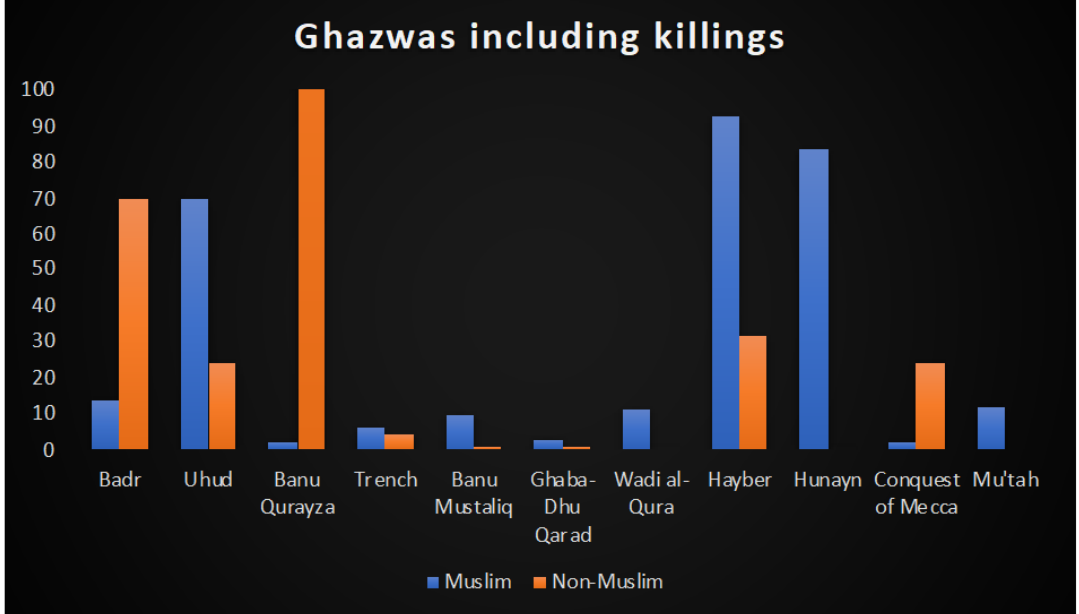
Figure 1. Ghazwas in Islamic history. (Source: Forum for Promoting Peace in Muslim Societies’ YouTube channel).